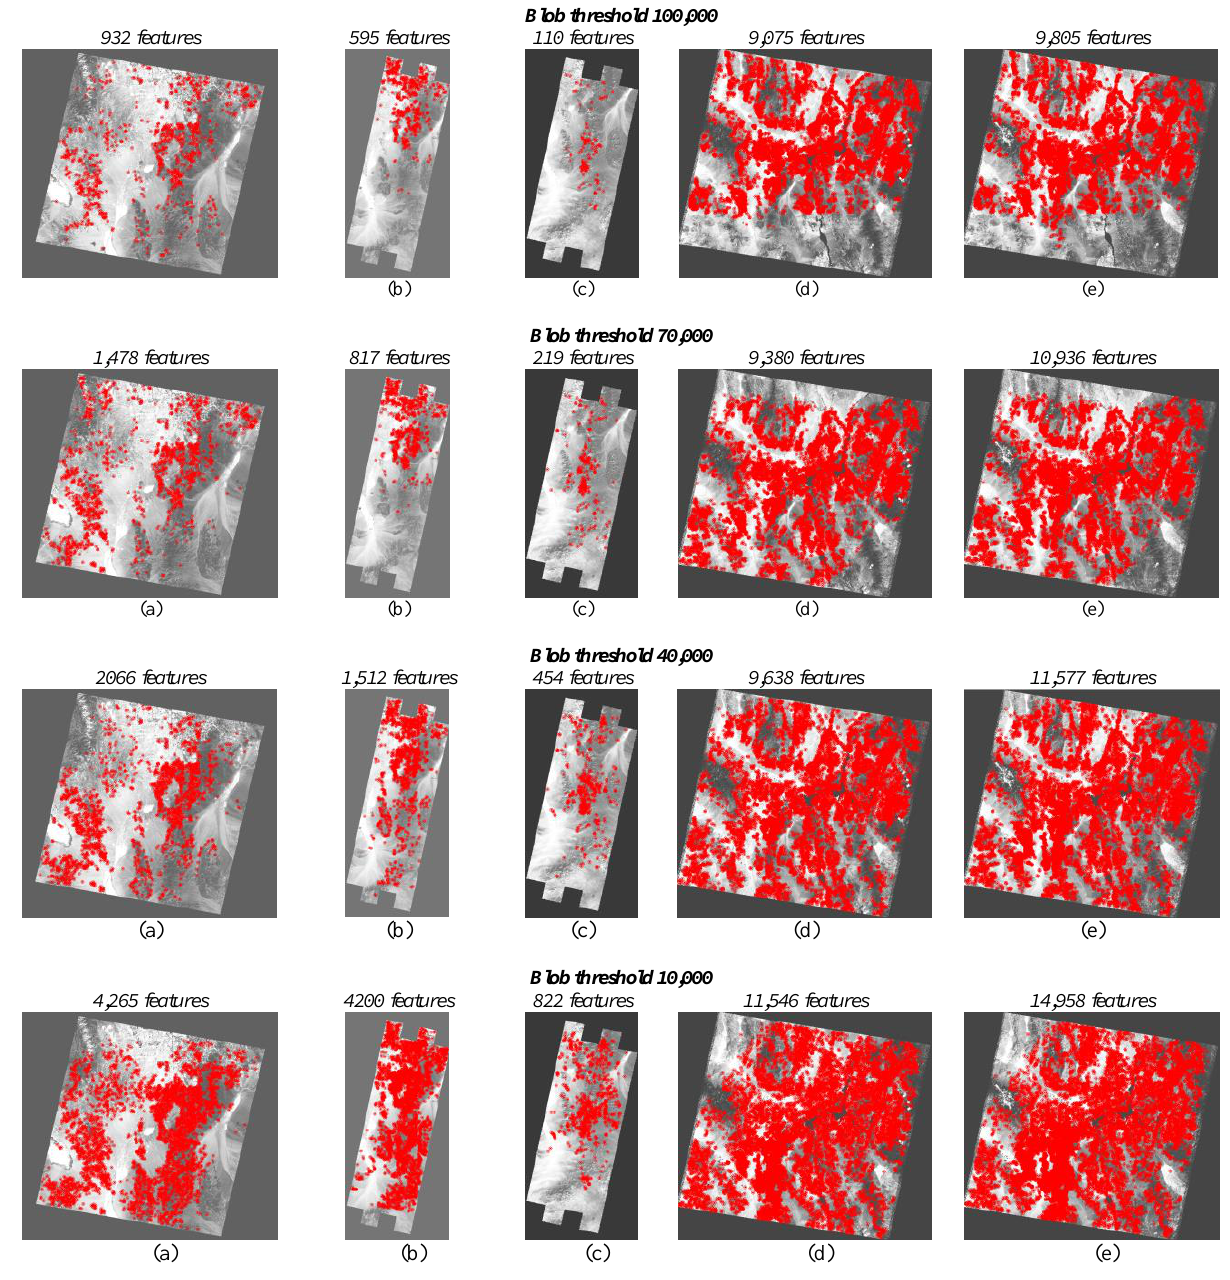
Figure 1. Multi-image features matched with a variable threshold for the blob detection. (a) Terra/ASTER ID #1 ; (b) EO-1/ALI ID #2 ; (c)